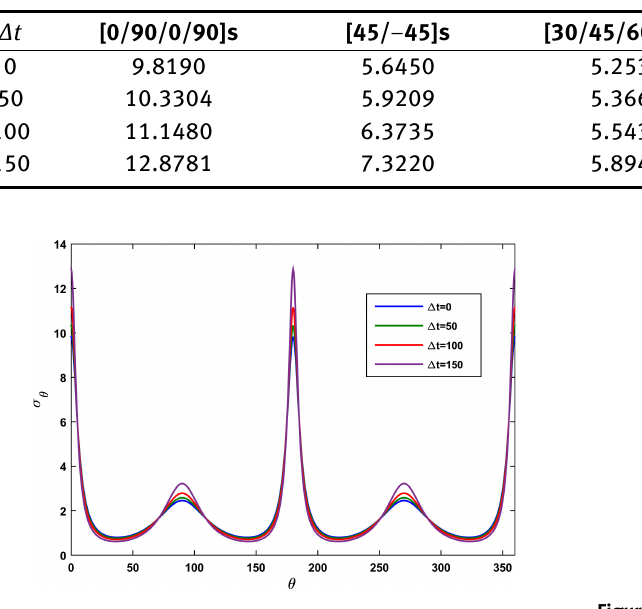
Figure 6: Effect of ∆t on σ θ around elliptical hole in orthotropic plate subjected to σ ∞ x = σ ∞ x = 1